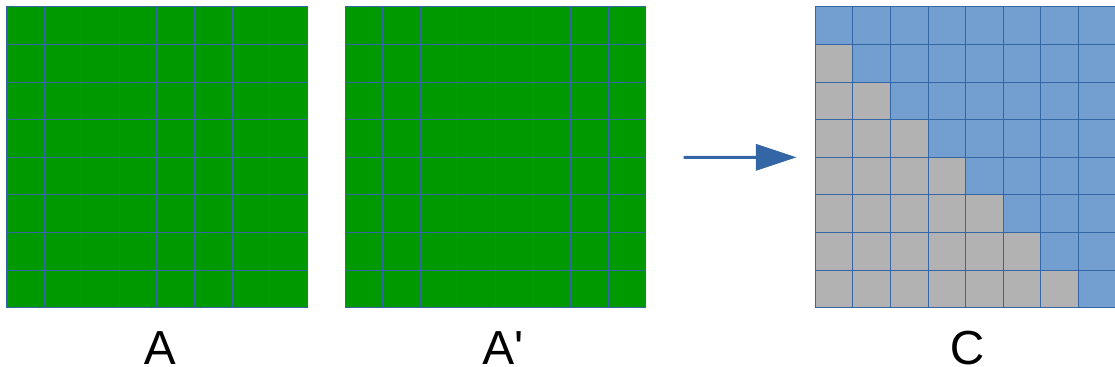
Figure 3. Matrix product of A · A (cid:48) . Green = cells used in computation, blue = cells to be computed, grey = duplicated